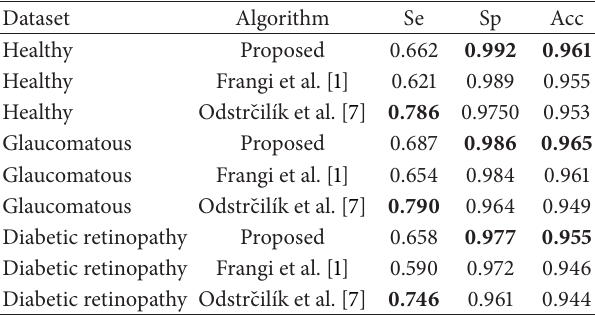
Table 5: Sensitivity (Se), specificity (Sp), and accuracy (Acc) measured for the three datasets separately in our high resolution database.